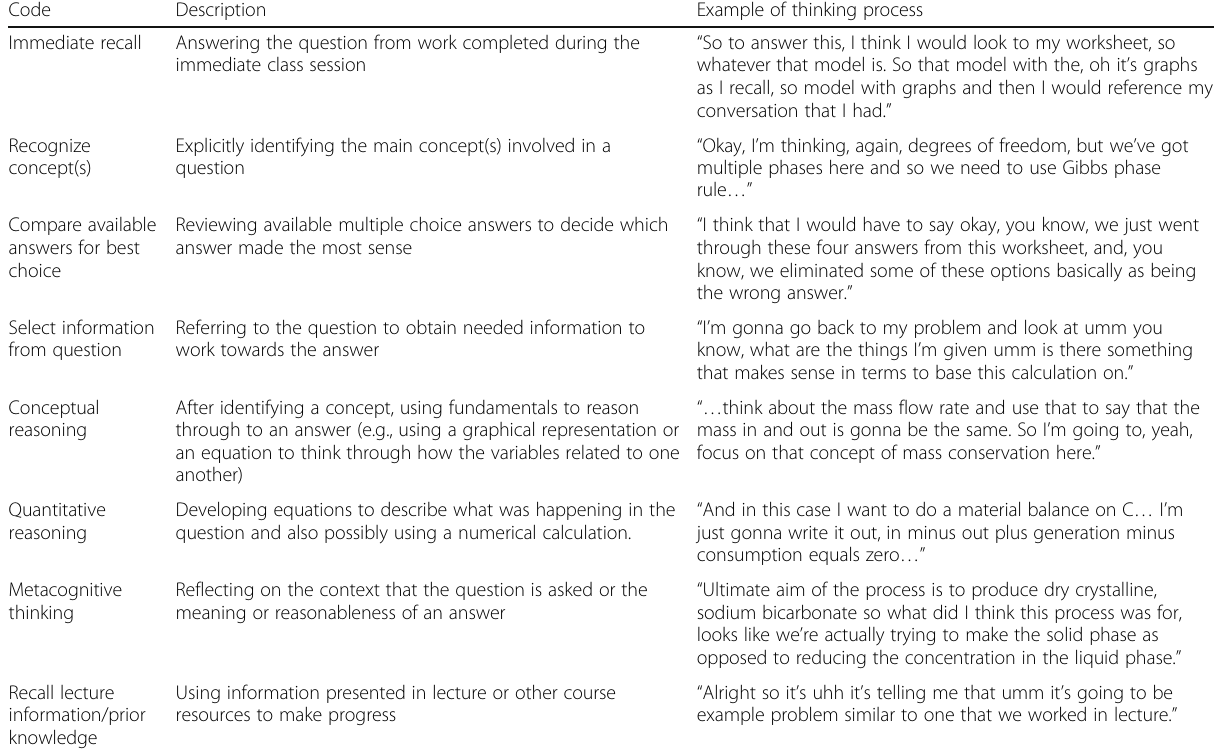
Table 1 Code definitions and example responses from for ARS